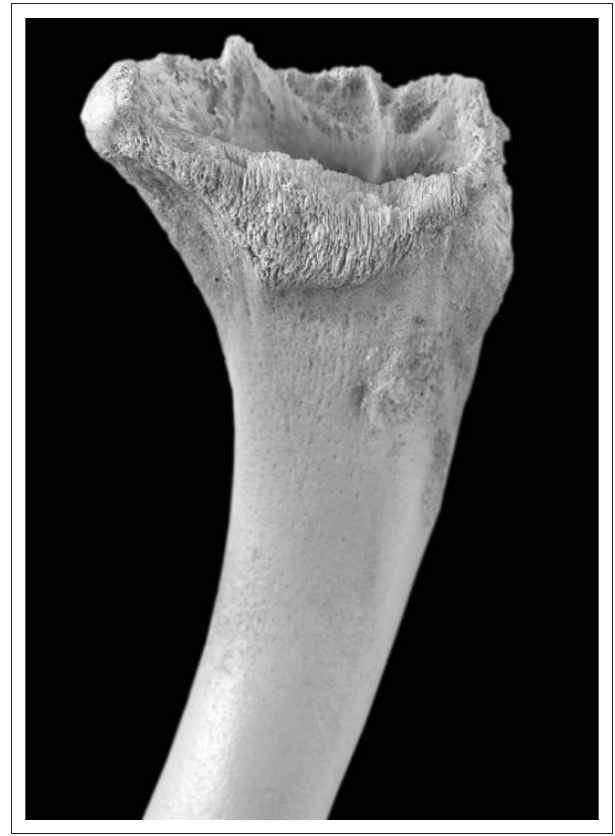
FIGURE 1: Nile crocodile humerus, case 1: Deep erosions of the outer surface of the epiphyseal cortex under the caput humeri.